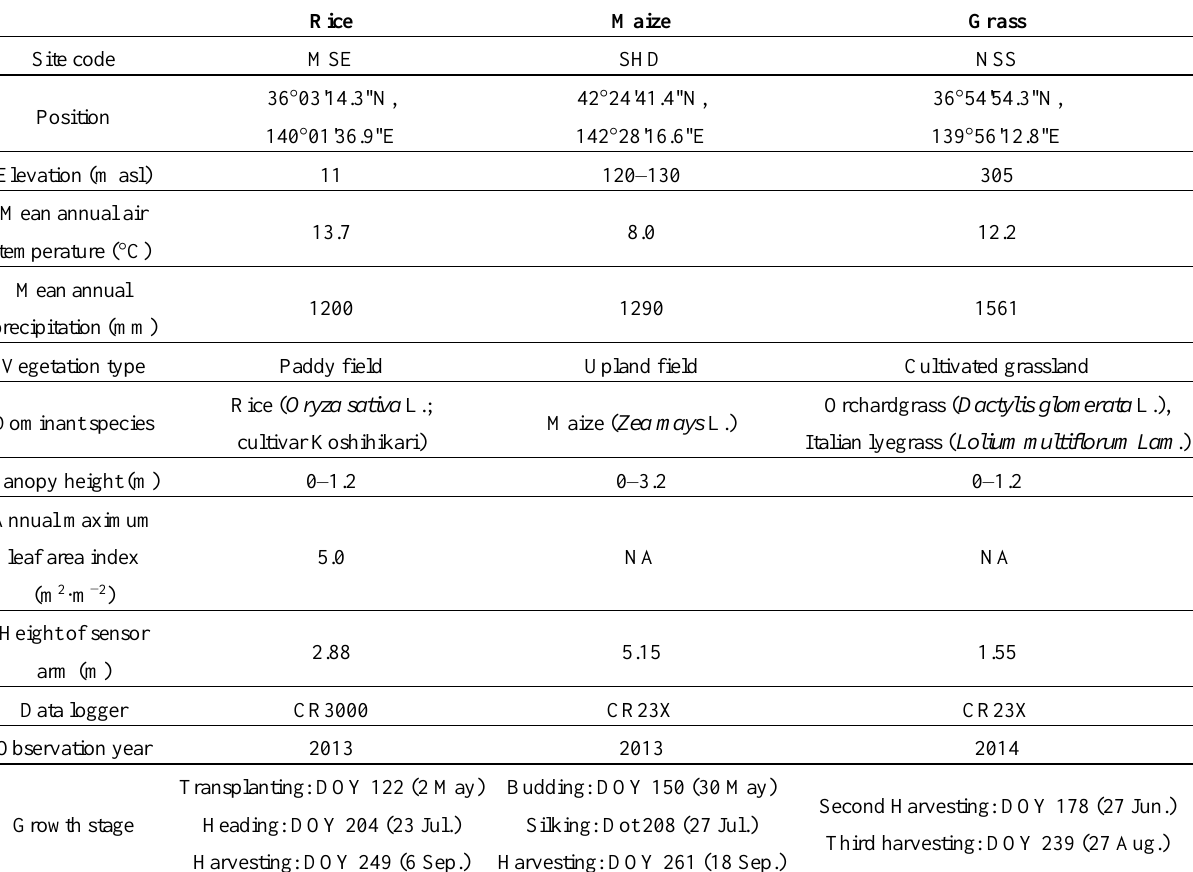
Table 1. Details of the study